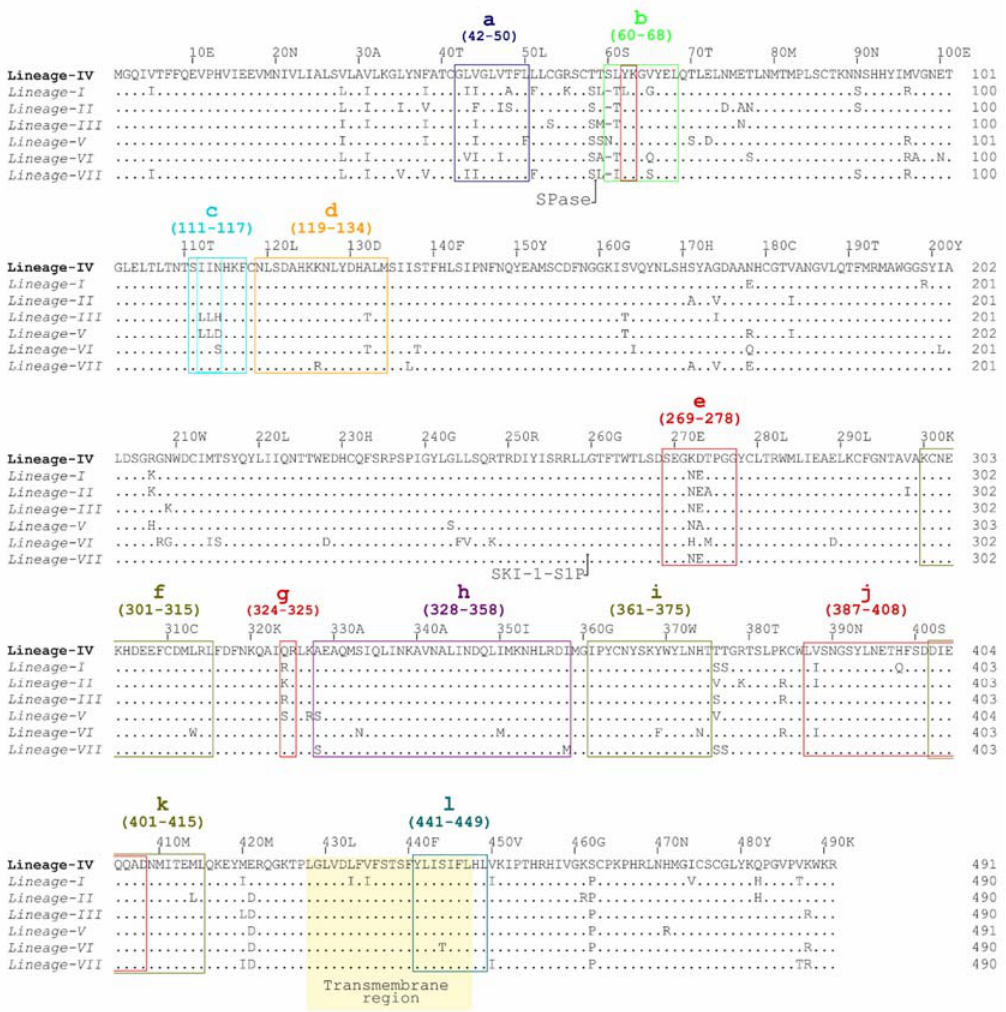
Figure 4. Aligned GP precursor amino acid sequence of LASV confirmed and proposed lineages. Multiple sequence alignment of prototype LASV strains selected from the literature (see Table 1 for detailed description) created with Clustal Omega in Jalview 2.11.0 [61] and manually annotated.